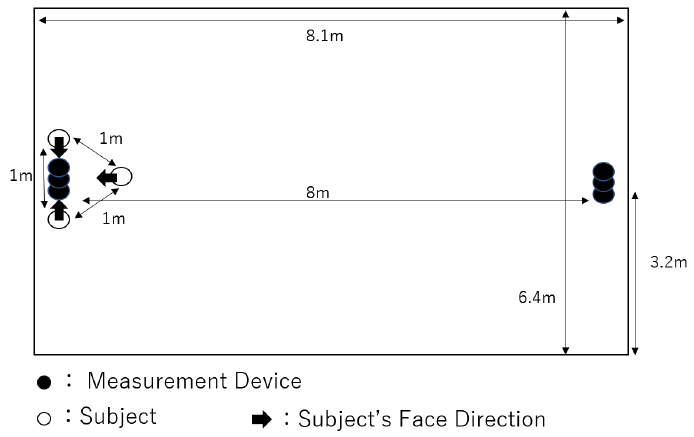
Figure 4. Position of subjects and measurement devices in Case 2.